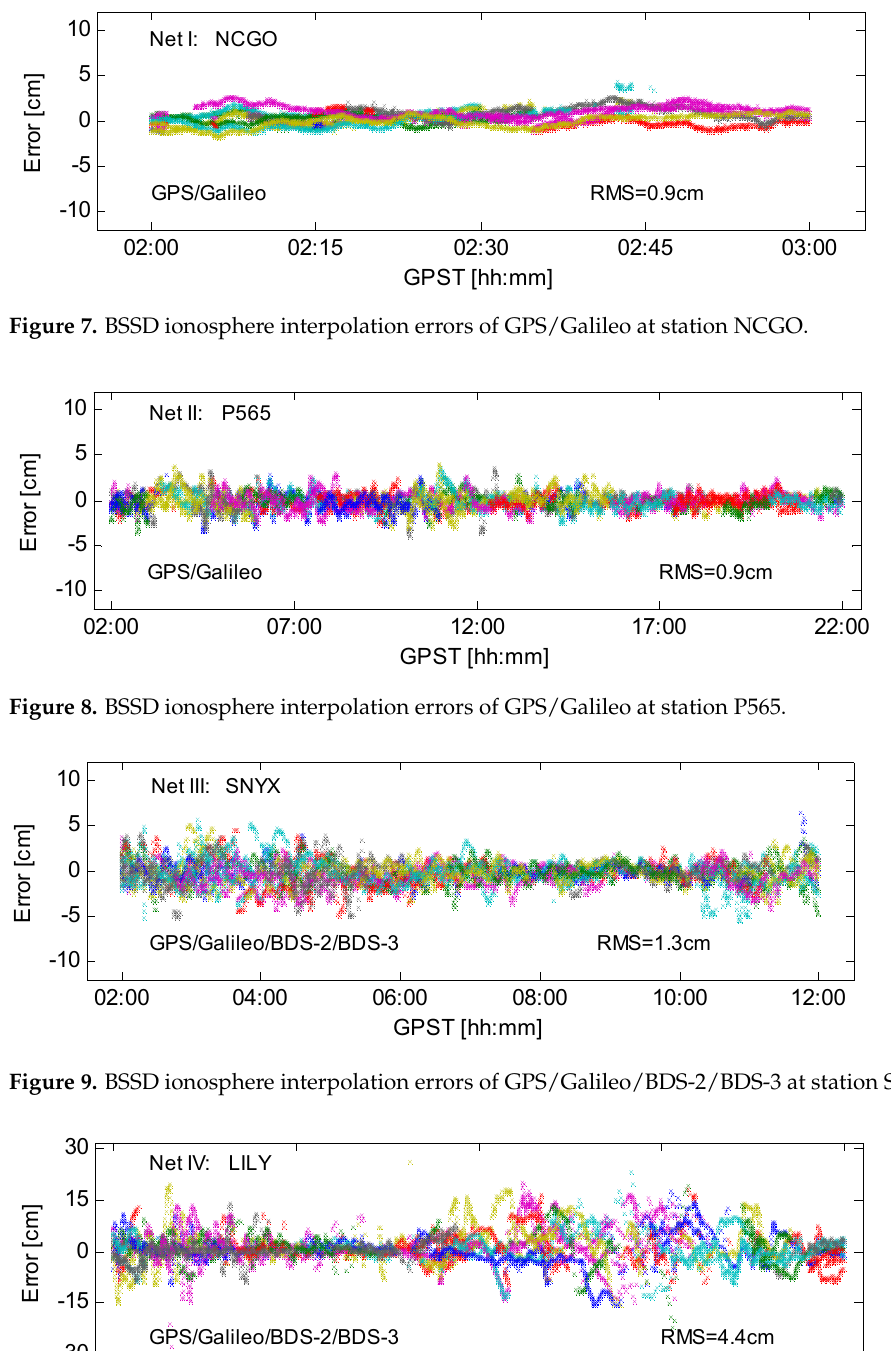
13 of 24 Figure 6. ZWD interpolation results of NCGO, P565, SNYX, and LILY. Figures 7–10 show the BSSD ionosphere errors of these four stations and among them, different colors indicate different satellites. For station NCGO, P565, and SNYX, the interpolation error of each satellite generally did not exceed 5 cm. For the entire period, the interpolation accuracy was 0.9 cm, 0.9 cm, and 1.3 cm, respectively. The interpolation error of LILY was relatively large, even exceeding 15 cm in certain periods. The main rea-